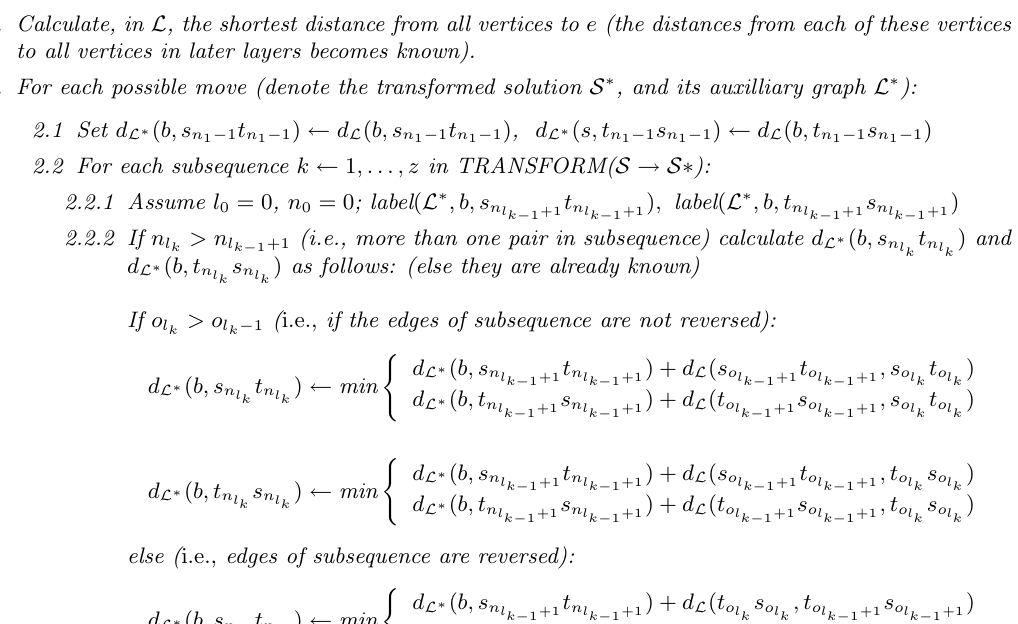
Algorithm 2 (Local search iteration using the complexity reduction